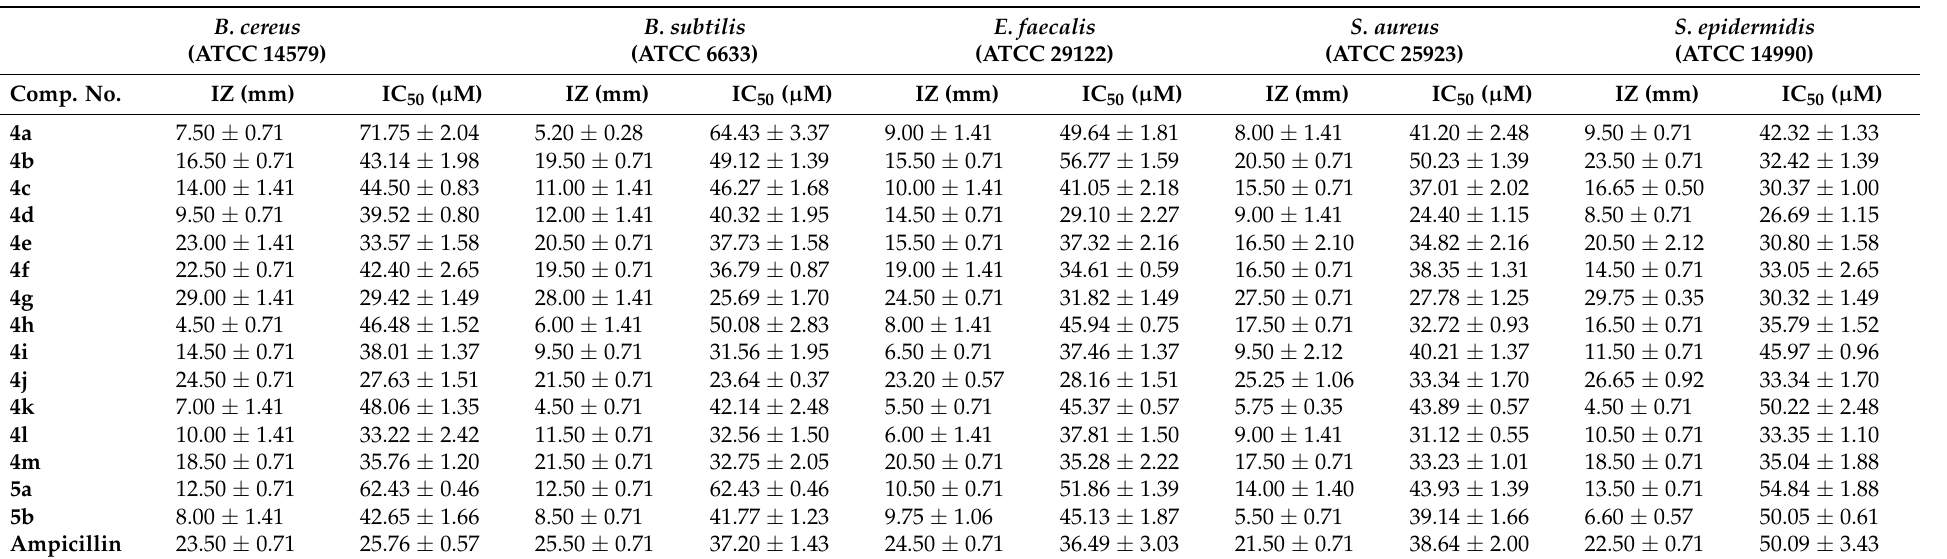
Table 2. Antibacterial evaluation of the studied compounds against some Gram-positive bacterial strains by measurement of the diameters of the inhibition zones (IZs, mm) and determination of the half-maximal inhibitory concentrations (IC 50 s, µ M). Ampicillin was used as the reference antibiotic. Results were obtained from three independent